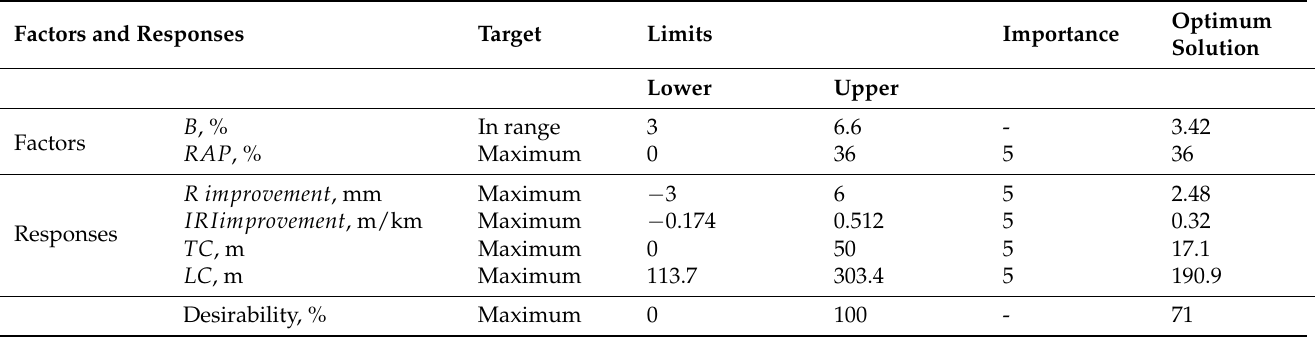
Table 5. Optimal solution for WMA mixture containing RAP for use in wet